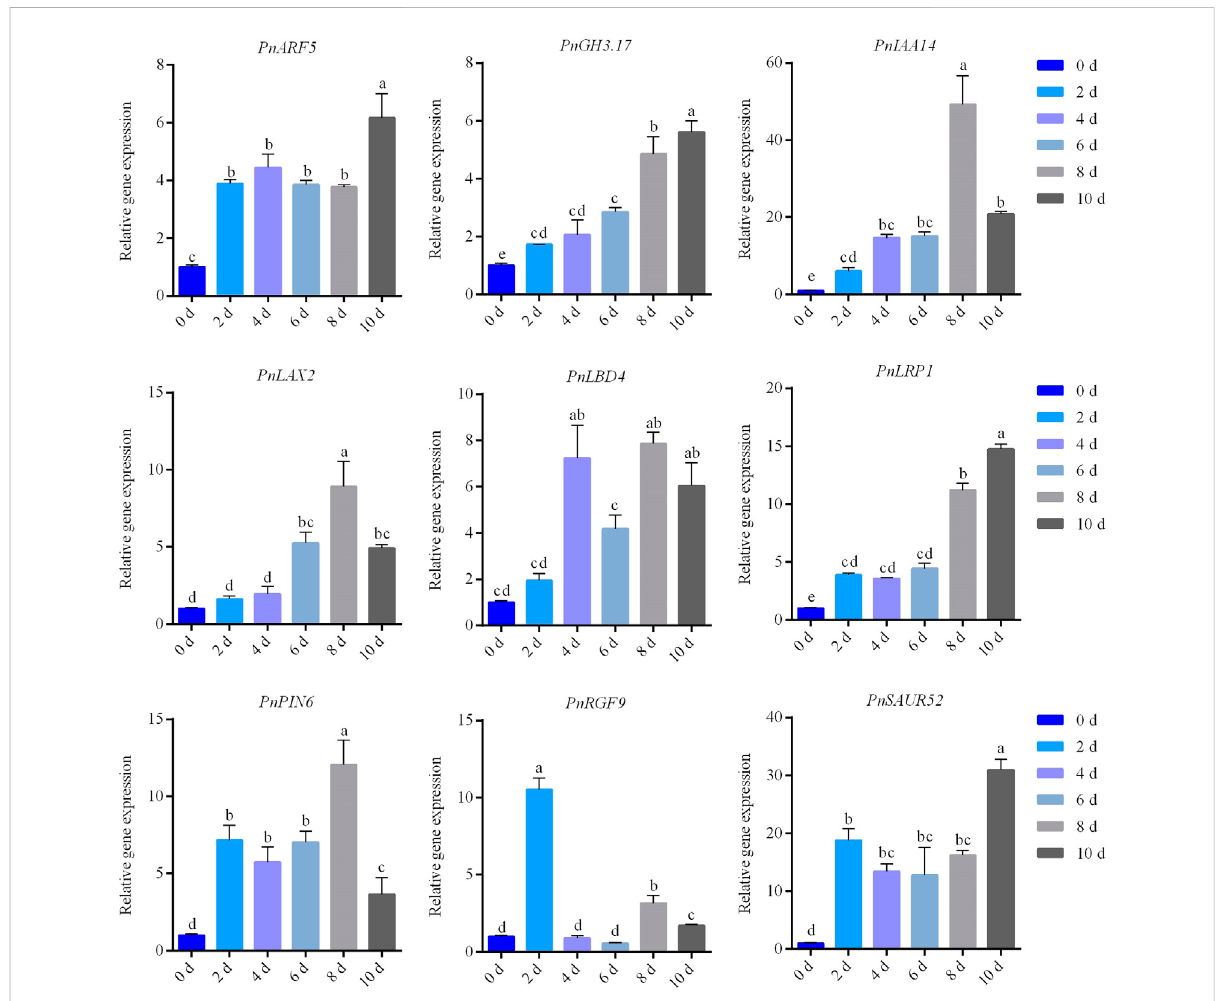
FIGURE 5 qRT-PCR results of PnARF5 , PnGH3.17 , PnIAA14 , PnLAX2 , PnLBD4 , PnLRP1 , PnPIN6 , PnRGF9 , and